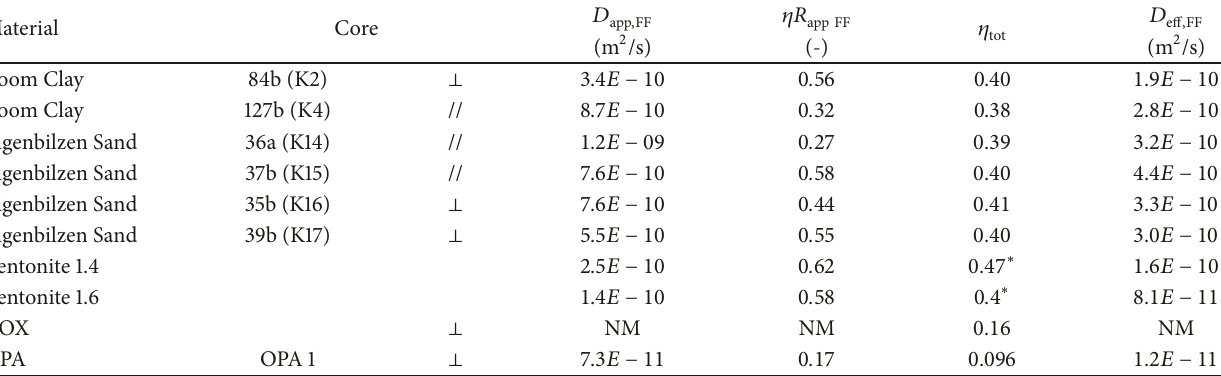
Table 3: HTO Diffusion coefficients, fitted capacity factor, and total porosity assuming fixed filter transport parameter values (Fixed Filter,